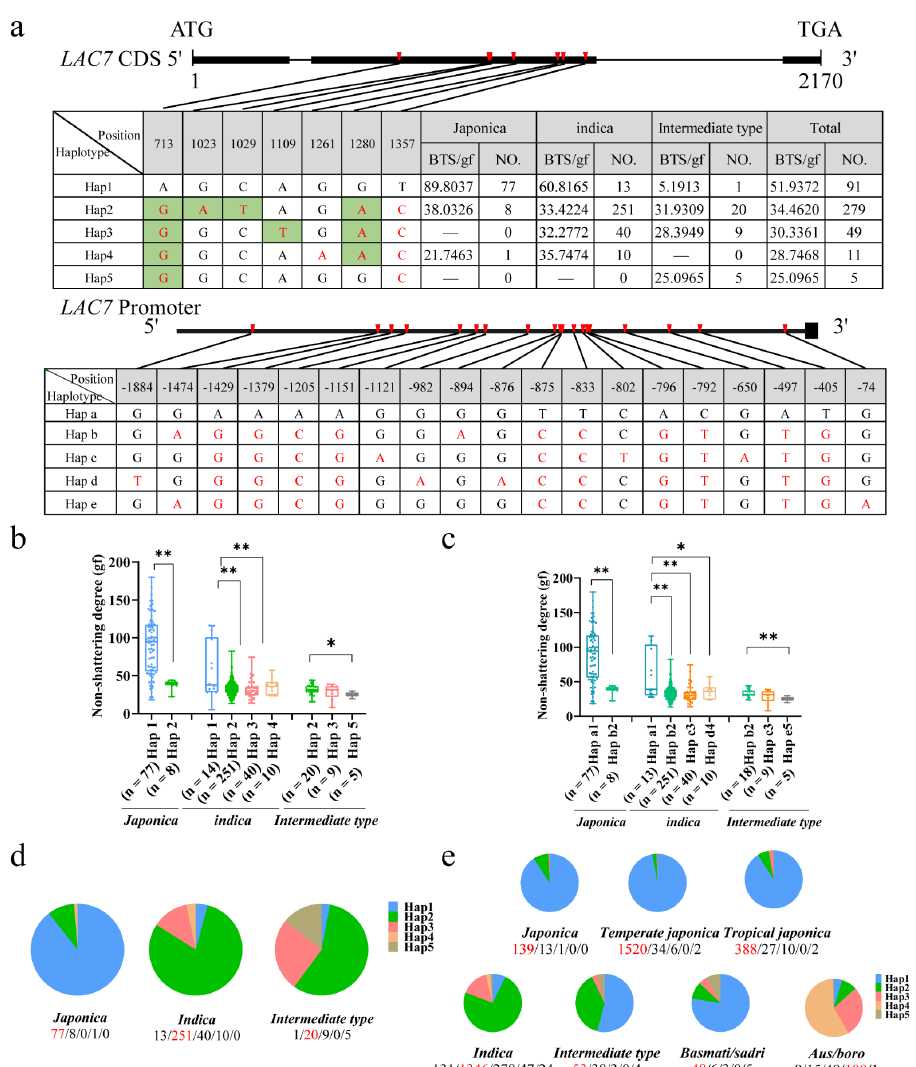
Figure 7. Candidate gene analysis of qBTS1 : ( a ) Haplotype analysis of LAC7 coding regions in 435 naturally occurring rice cultivars. Red letters symbolize different nucleotides, and green-marked letters symbolize nonsynonymous substitutions. ( b ) Haplotype analysis of the candidate gene LAC7 in 435 natural rice cultivars (coding sequence (CDS) regions); ** indicates an extremely significant difference at the 1% level. * indicates a significant difference at the 5% level. ( c ) Haplotype analysis